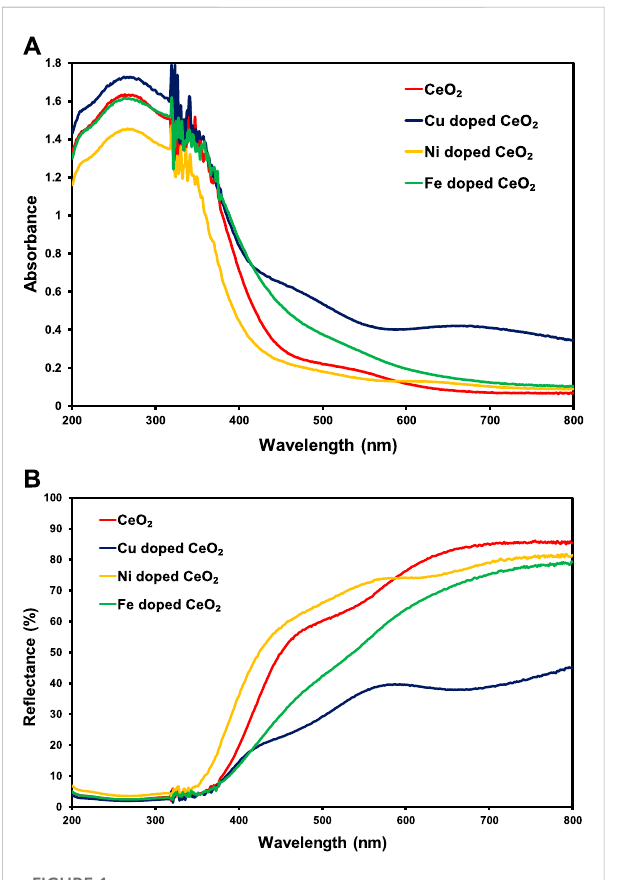
FIGURE 1 The comparison of solid-state (A) absorption and (B) re fl ectance (%) spectra of pristine CeO 2 and doped CeO 2 .